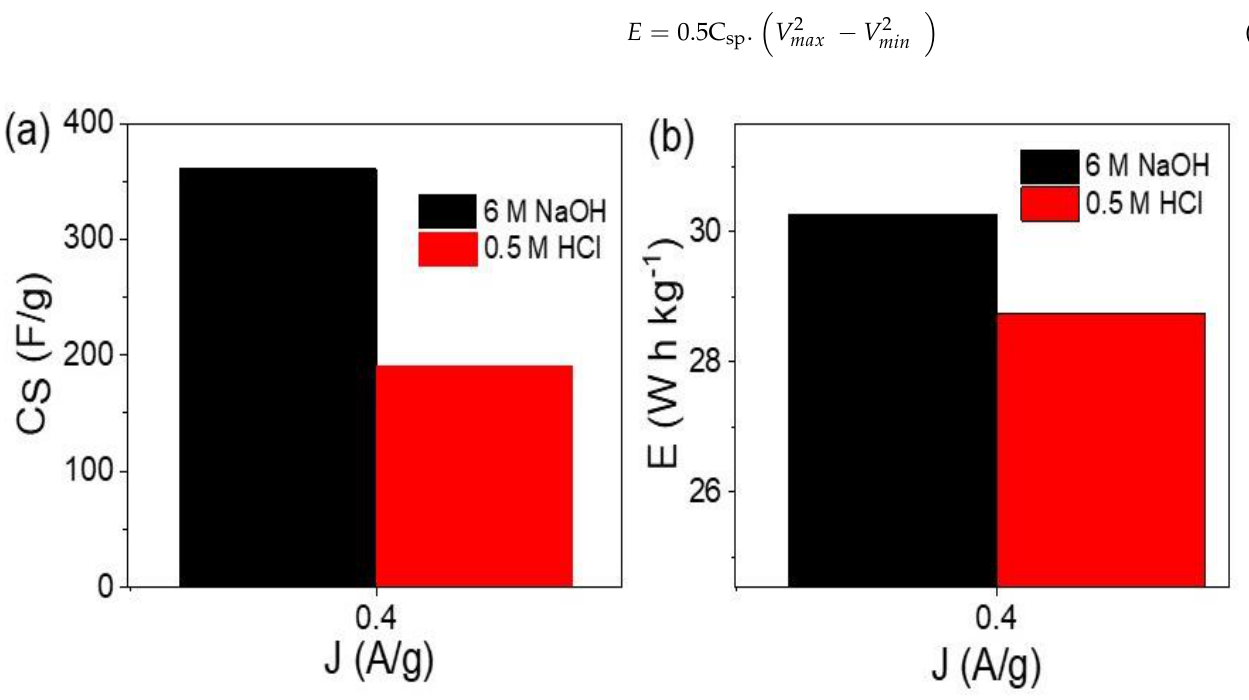
Figure 5. ( a ) The specific capacitance and ( b ) energy density for the prepared two symmetric elec- trodes supercapacitor in acid and base